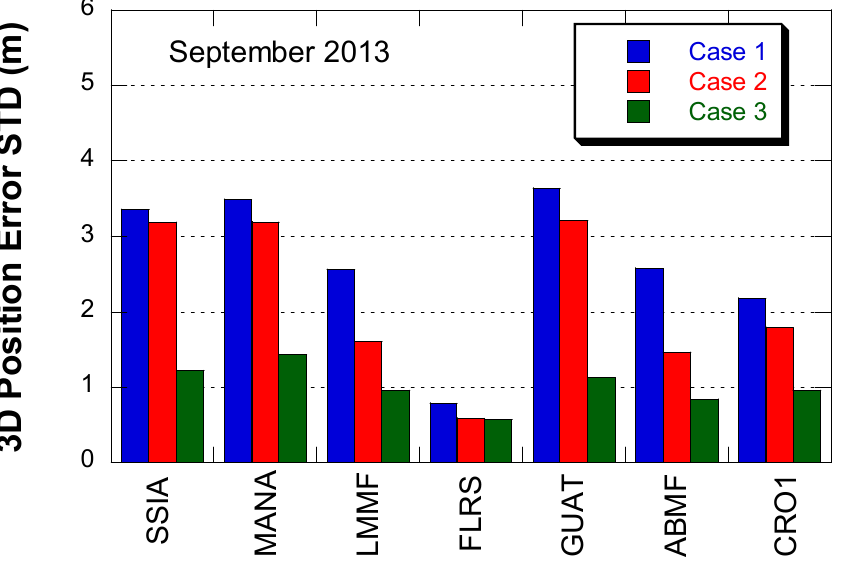
Figure 13. 3D position error STD for different positioning methods at seven IGS stations in September 2013.